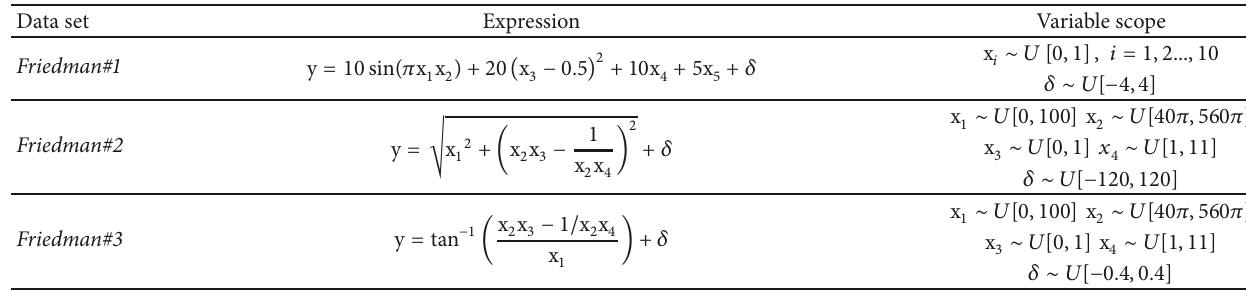
Table 4: Test function expressions.